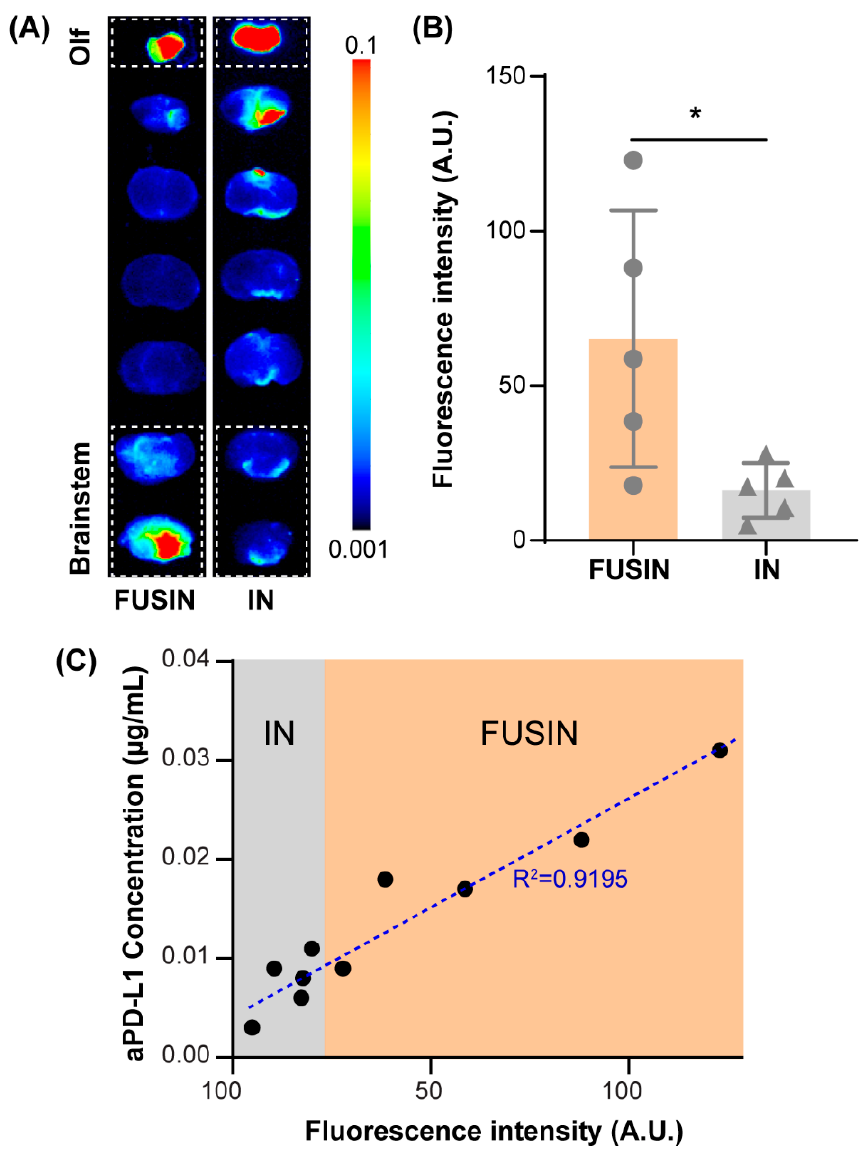
Figure 2. Focused-ultrasound-mediated intranasal (FUSIN) delivery of 800CW-aPD-L1 to the brainstem. ( A ) Fluorescence images of representative ex vivo mouse brain slices. The olfactory bulb (Olf) was in the top slice. The targeted location of the FUS was located at the right side of the brainstem. The dashed box highlights the brain slices containing the brainstem. ( B ) Fluorescence quantification of the 800CW-aPD-L1 delivery efficiency to the brainstem. ( C ) The relationship between the fluorescence intensity measured by ex vivo fluorescence imaging and the aPD-L1 concentrations measured by ELISA (*: p < 0.05).